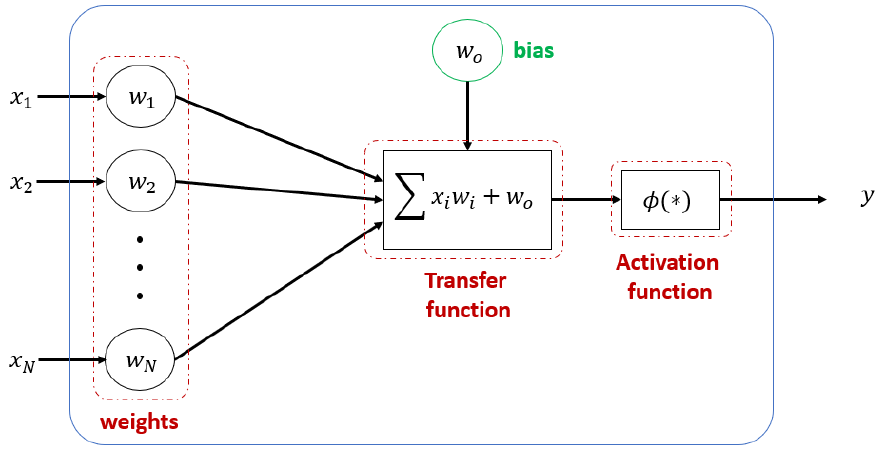
Figure 9. Artificial neuron architecture.